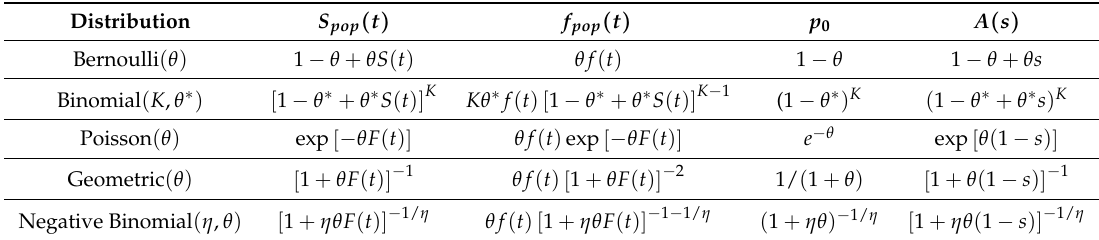
Table 1. Survival function S pop ( t ) , density function f pop ( t ) , and cured fraction of different distributions of latent